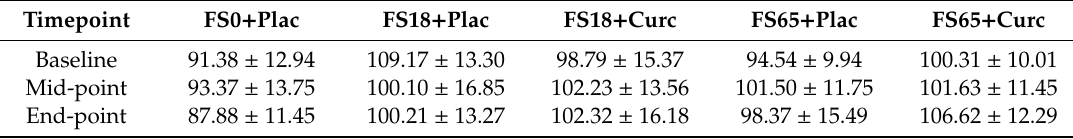
Table 4. Mean ferritin ( µ g / L) values (normal ferritin sub-group) per treatment group and timepoints (mean ±